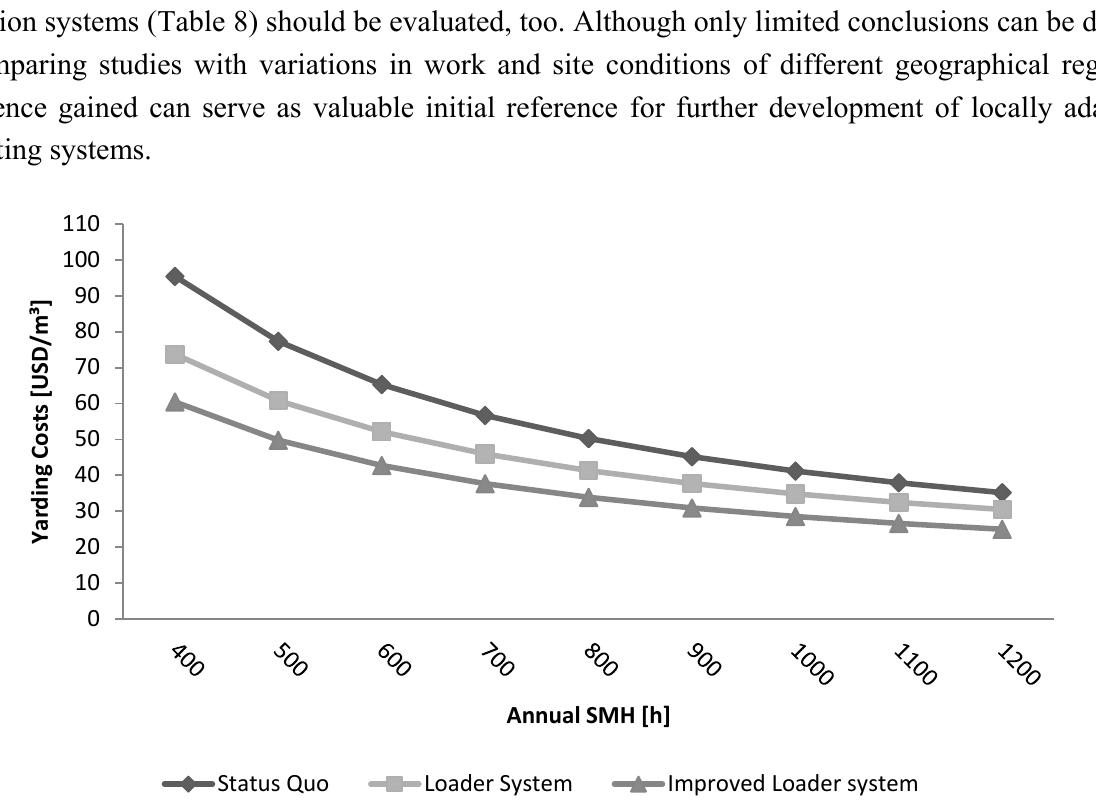
Figure 6. Yarding costs (USD/m³) as a function of annual utilization hours (SMH) related to the modeled productivity (m³/h) and a 10 year depreciation period with associated system overhead costs for the three scenarios: “Status Quo” (2.50 m³/h), “Loader System” (2.50 m³/h) and “Improved Loader System” (3.05